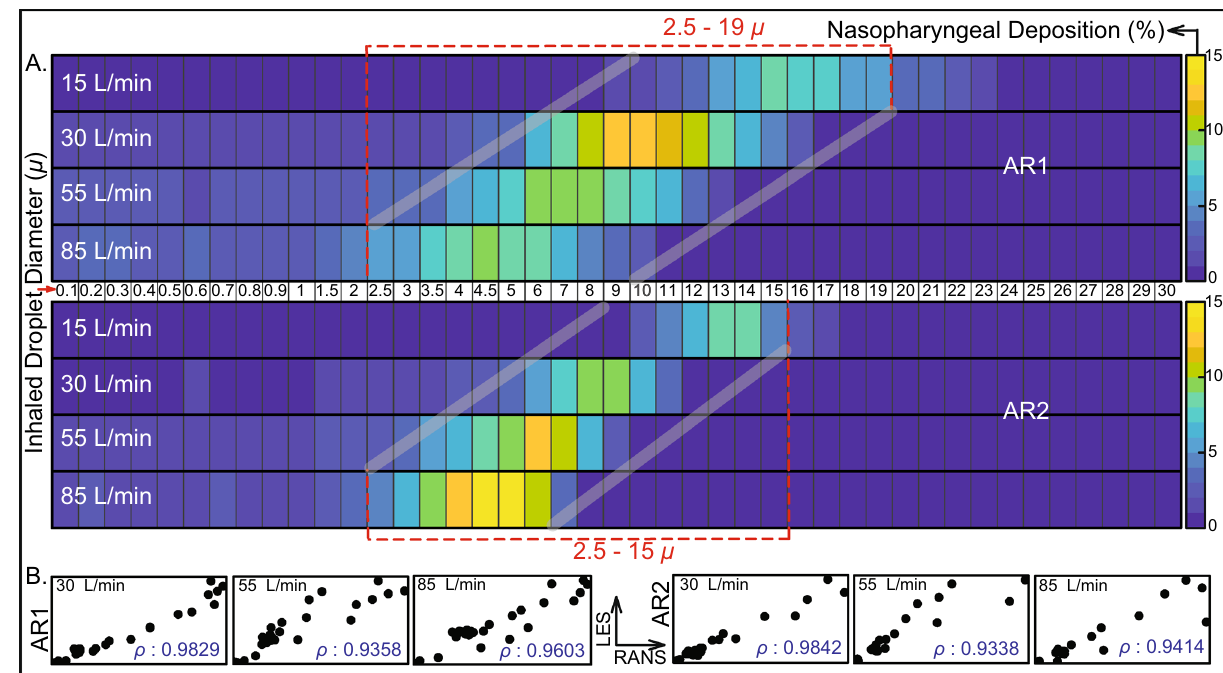
Figure 3. Computed trends of inhaled droplet transport to the nasopharynx: ( A ) Visuals of heat-maps for inspiratory transmission trends in AR1 (top map) and AR2 (bottom map), showing the percentage of droplets of each size undergoing nasopharyngeal deposition (NPD). The droplets are assumed to undergo environmental dehydration before being inhaled; hence the droplet density is 1.3 g/mL. Data for different inhaled airflow rates are arranged along separate rows. Tracked droplet sizes are along the horizontal axis (positioned between the two heat-maps for AR1 and AR2). NPD peaks for droplets sized between 2.5 and 19 µ in AR1 and 2.5 and 15 µ in AR2. ( B ) The correlation between RANS-based SST k- ω and LES results for the higher airflow rates i.e. 30, 55, and 85 L/min; therein the first three frames (bottom-left) are for AR1, the other three frames (bottom-right) correspond to data for AR2. The frames are on an aspect ratio of 0.5; ρ represents the Pearson’s correlation coefficient. Heat-maps in ( A ) are generated by post-processing the simulated data on MATLAB R2020a (MathWorks, Natick, Massachusetts; link to softw are homep age). The correlation plots in ( B ) are generated on Mathematica 12.0 (Wolfram Research, Champaign, Illinois; link to softw are homep